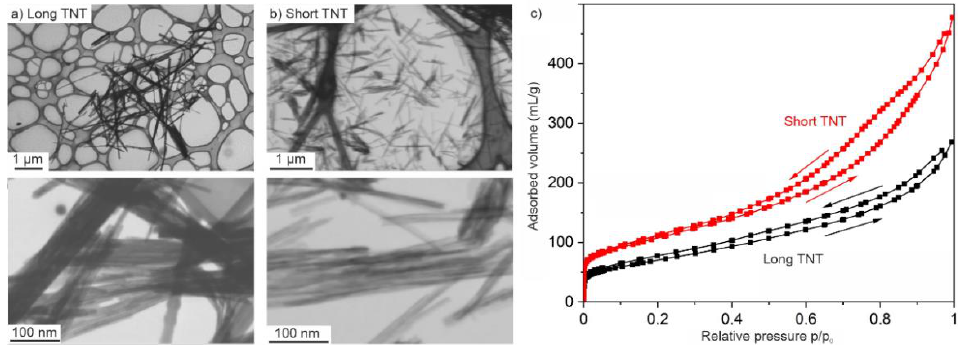
Figure 2. Long and short TNTs: ( a ) TEM overview and detail images of long TNTs, ( b ) TEM overview and detail images of short TNTs, ( c ) nitrogen sorption analysis of long and short TNTs. Table 1. Specific surface area and pore volume of TNTs prior to and after impregnation with Pd or Pt.